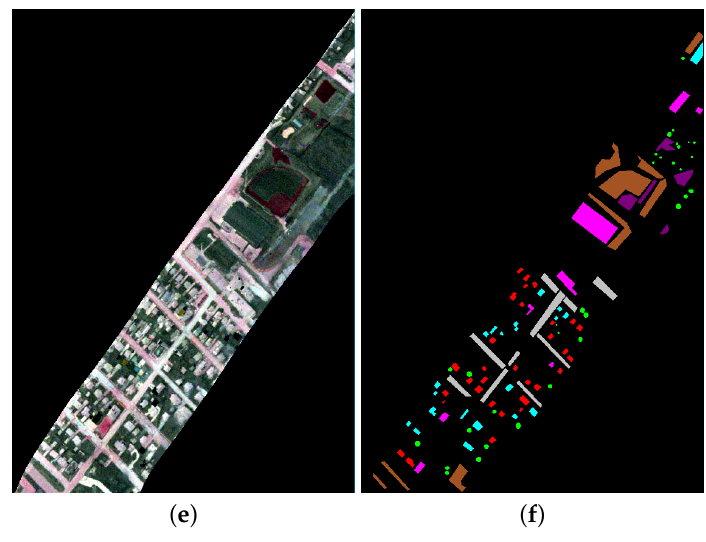
Figure 3. False color composite images of ( a ) Indian Pines; ( c ) KSC and ( e ) GRSS_DFC_2014 data sets and the ground truths ( b , d , f ). Each color corresponds to a certain class.